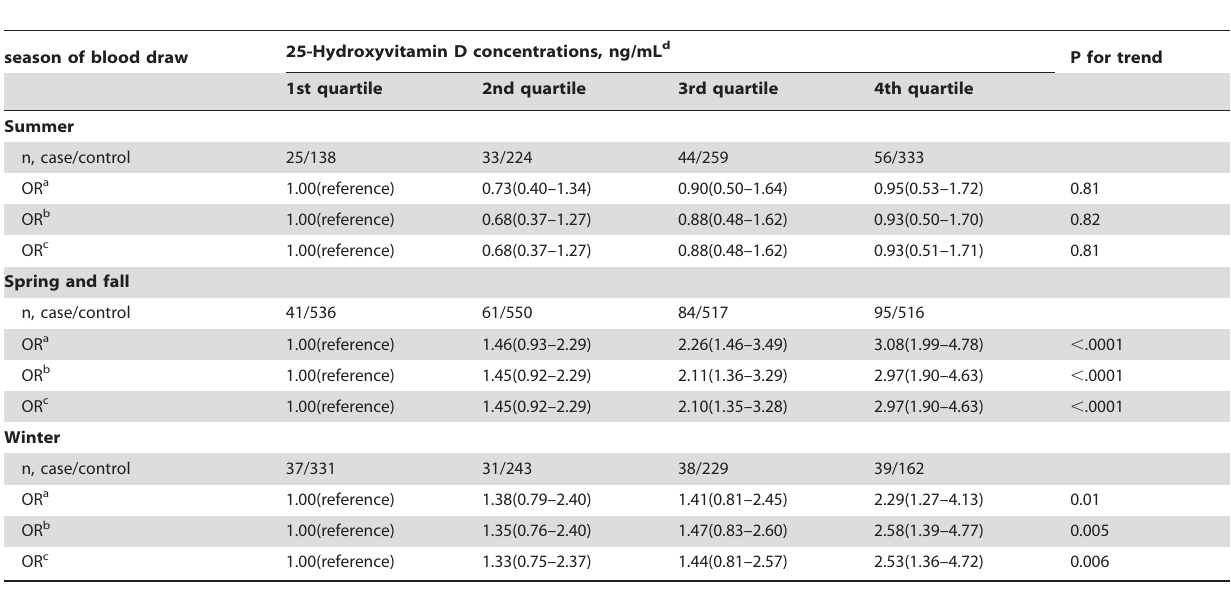
Table 4. Odds ratios of BCC by quartile of plasma vitamin D concentrations in NHS and NHS II (stratified by season of blood draw).